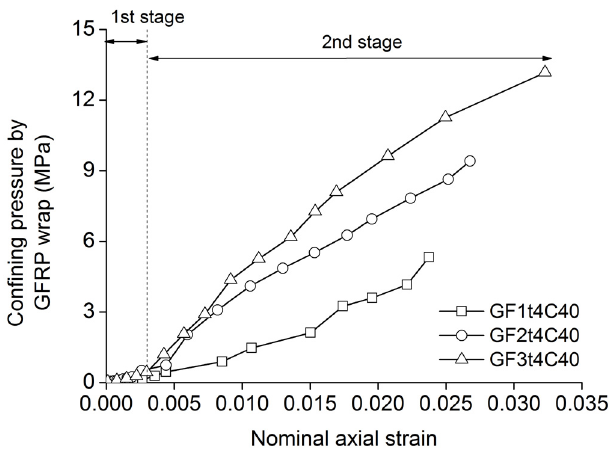
Figure 7. Confining pressure from the GFRP wrap.